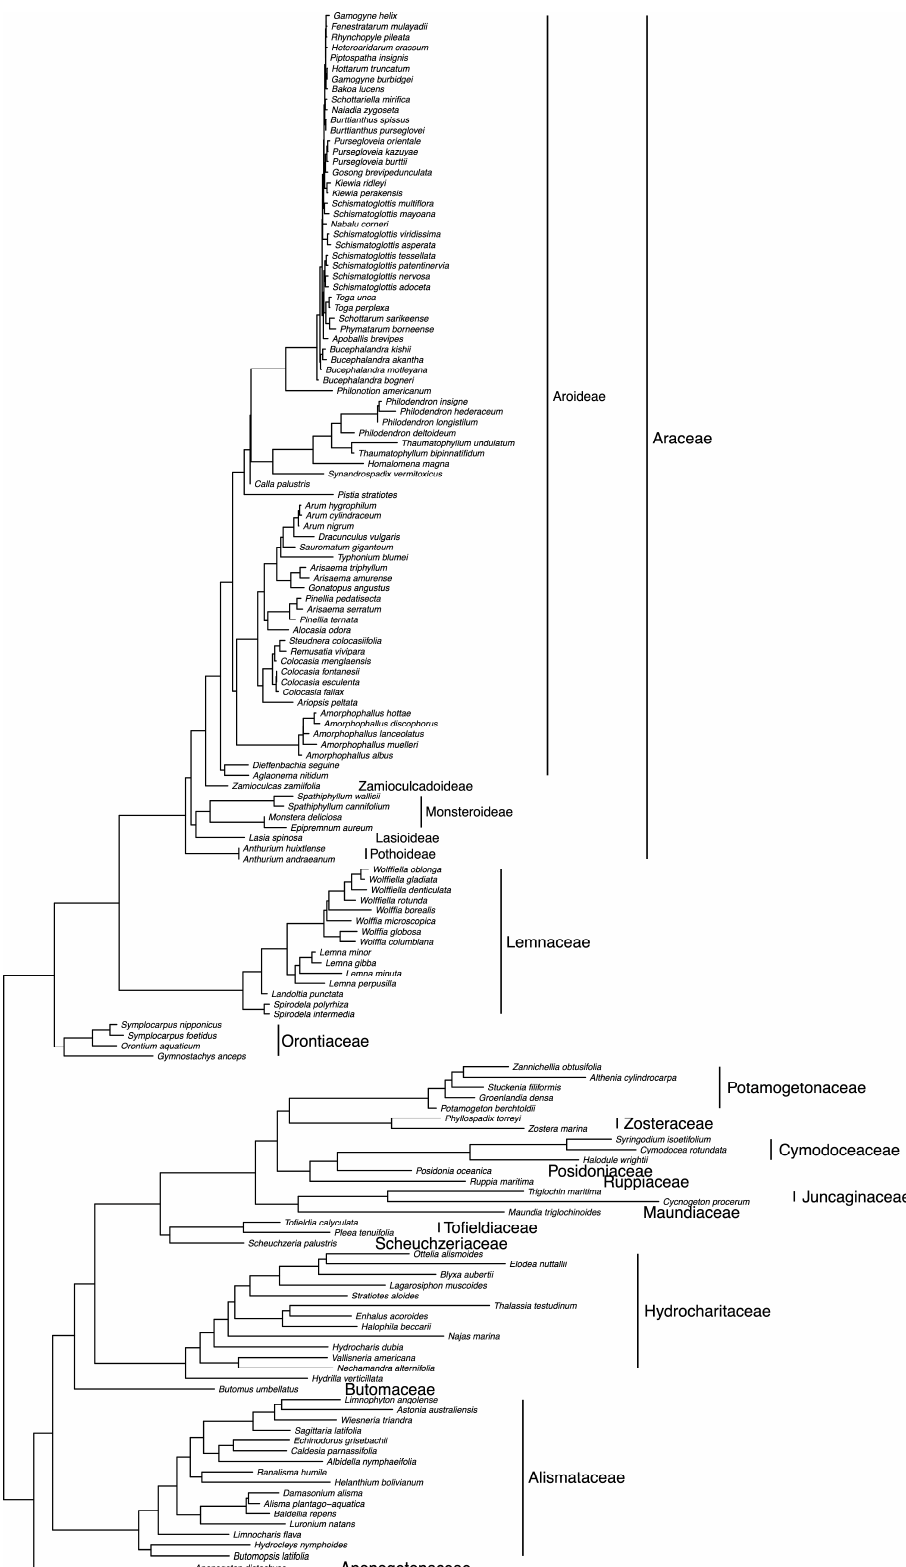
Figure 5. Phylogeny of Arales, constructed using combined DNA sequence data from nuclear ribosomal genes and spacers (18S and 5.8S rRNA, and the ITS-1 and ITS-2 spacers). The tree represents a maximum likelihood tree, constructed in IQ-TREE [18] using default